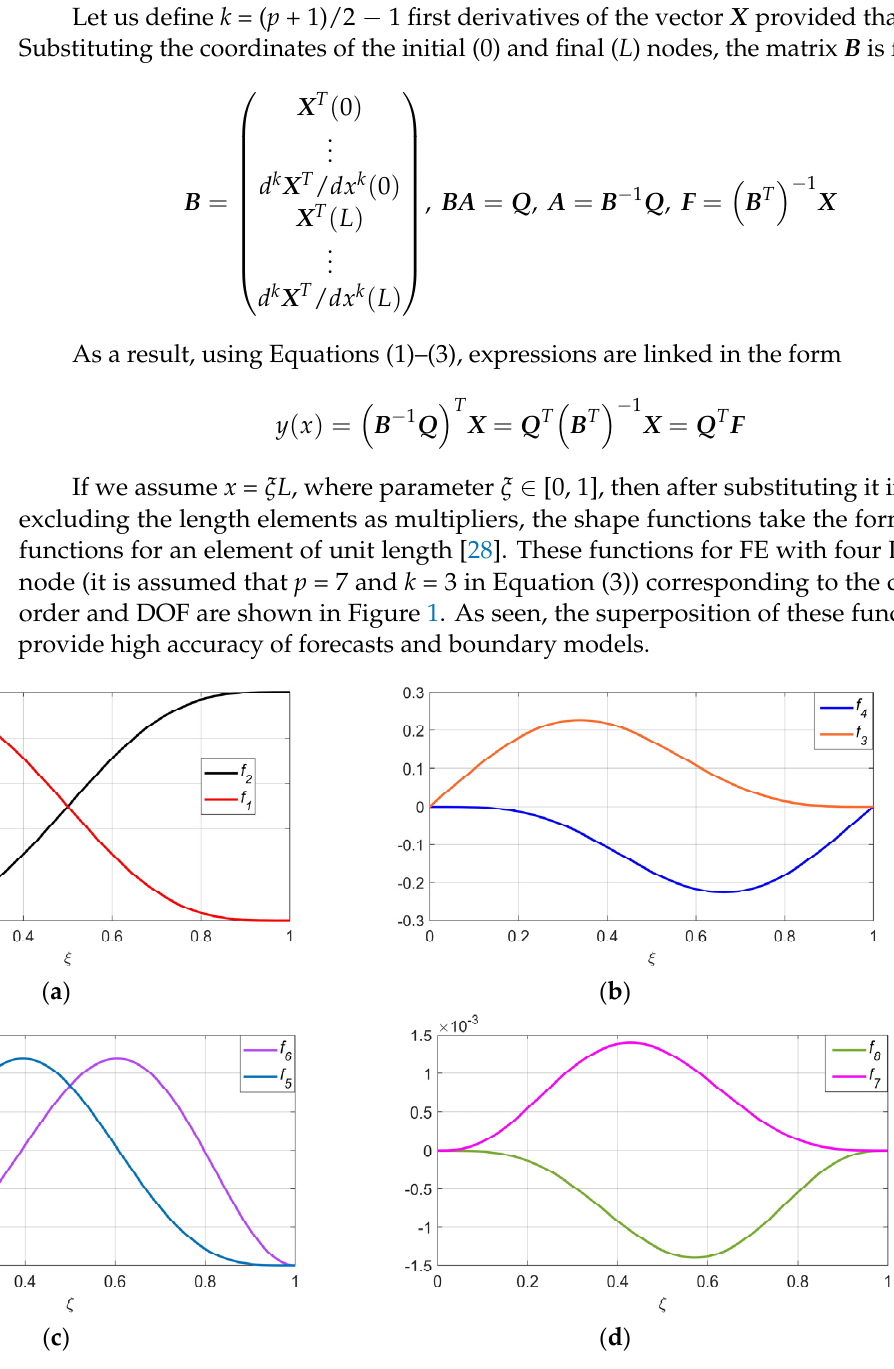
Figure 1. Basis functions of an FE with 4 DOF in a node: ( a ) offset, ( b ) rotation, ( c ) rotational rate, ( d ) intensity of rotational rate.